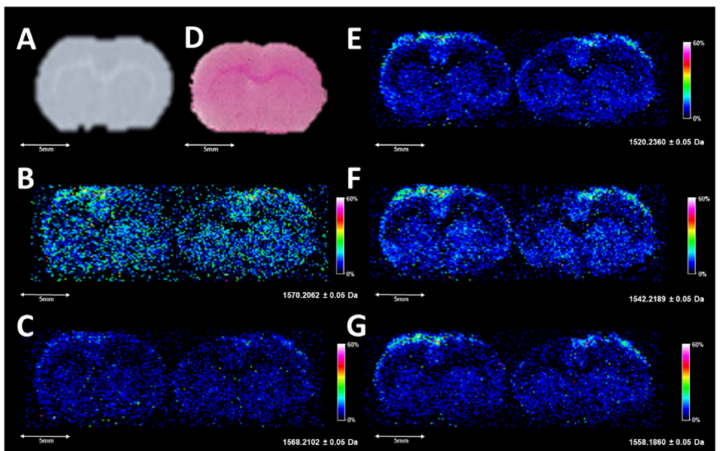
Figure 4. ( A ) is a digitized scan of the left section profiled by DESI-MSI, ( D ) is a completed H&E- stained serial section collected 220 µ m from the DESI sampled tissue, with ( B ) (1570.2060 ± 0.05), ( C ) (1568.2100 ± 0.05), ( E ) (1520.2360 ± 0.05), ( F ) (1542.2190 ± 0.05), and ( G ) (1558.1860 ± 0.05) corresponding to the top five images in a m / z window from 1400 to 1600. In the images, the highest ion intensities are white and the lowest ion intensities are